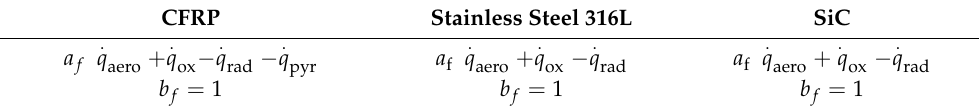
Table 3. PDE parameters a and b on the front surface of CFRP, stainless steel 316L and SiC.